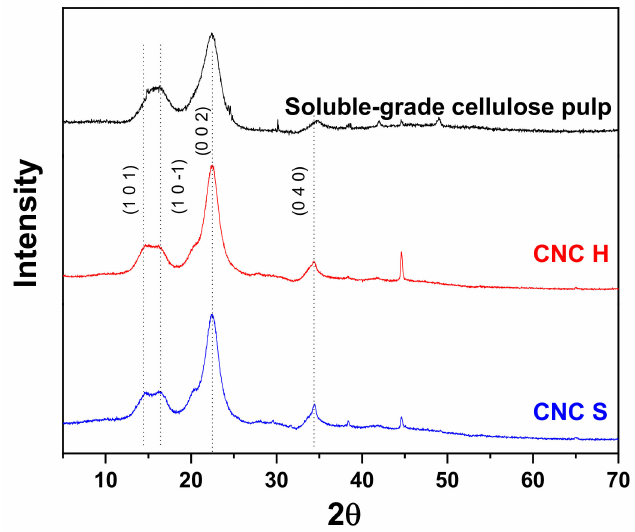
Figure 5. XRD spectra comparison for soluble-grade cellulose pulp, CNC-H (E10H), and CNC-S